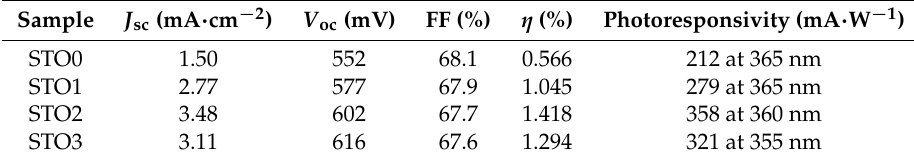
Table 1. Detailed data of short-circuit photocurrent density ( J sc ), open-circuit photovoltage ( V oc ), fill factor (FF), power conversion efficiency ( η ) , and photoresponsivity of all